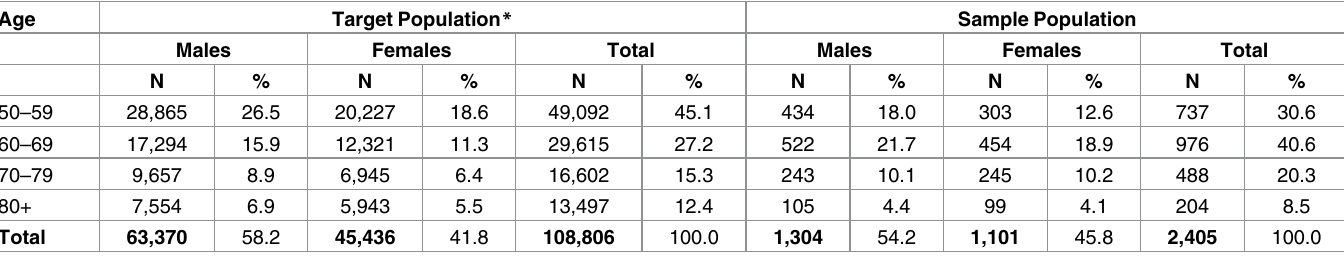
Table 1. Target population and sample examined in Wurno health zone,